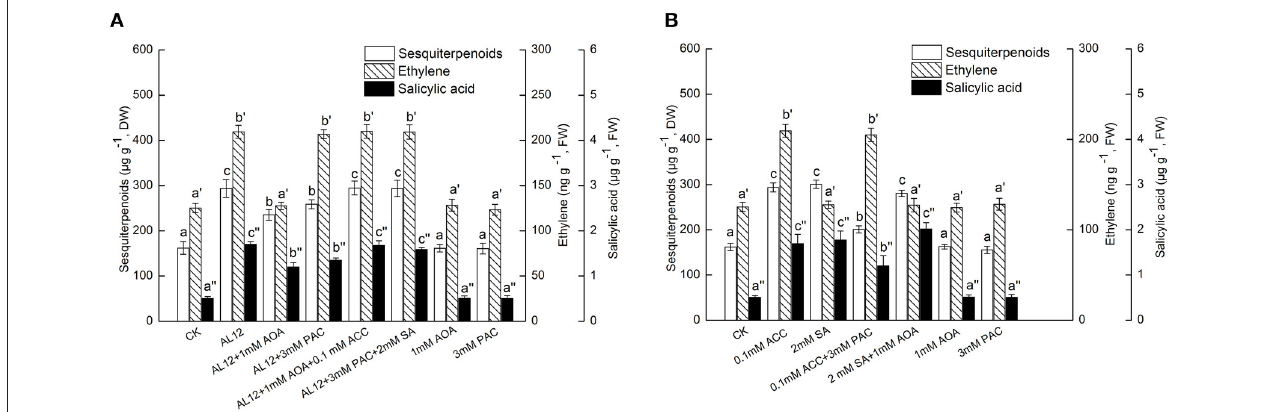
FIGURE 3 | (A) Interaction between ethylene and SA signaling pathways for endophytic fungus AL12-induced sesquiterpenoids accumulation in Atractylodes lancea plantlets. Thirty-day-old plantlets treated with 5-mm AL12 mycelial disks, 1 mM AOA, 3 mM PAC, 0.1 mM ACC, and 2 mM SA were harvested after 15 days to determine the sesquiterpenoids, ethylene and SA contents. Inhibitors were added 1 day prior to endophytic fungus AL12 inoculation or exogenous signal donor application. Controls were established using equal sized potato dextrose agar disks. Values are the means of three independent experiments ± SD. Bars with different lowercase letters (e.g., a, b, c; a ′ , b ′ , c ′ ; a ′′ , b ′′ , c ′′ ) are significantly different ( P < 0.05). (B) Dependence of ethylene-induced sesquiterpenoids accumulation on SA in Atractylodes lancea plantlets. Thirty-day-old plantlets treated with 0.1 mM ACC, 2 mM SA, 1 mM AOA, and 3 mM PAC were harvested 15 days later to determine the sesquiterpenoids, ethylene and SA contents. Inhibitors were added 1 day prior to exogenous signal donor application. Controls were established using equal volume of double distilled water. Values are the means of three independent experiments ± SD. Bars with different lowercase letters (e.g., a, b, c; a ′ , b ′ , c ′ ; a ′′ , b ′′ , c ′′ ) are significantly different ( P < 0.05).